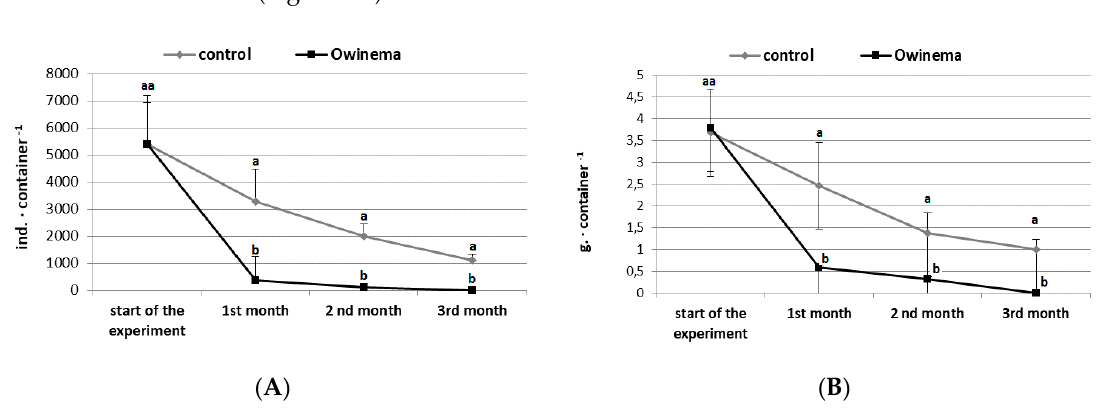
Figure 7. ( A ) Mean number of Diptera larvae (ind · liter − 1 ± SD) in experimental ecological boxes depending on the presence of Owinema bio-preparation (50 mln larvae m − 2 ). ( B ) Mean biomass of Diptera larvae (g · liter − 1 ± SD) in experimental ecological boxes depending on the presence of Owinema bio-preparation (50 mln larvae m − 2 ). a, b indicate significant differences.